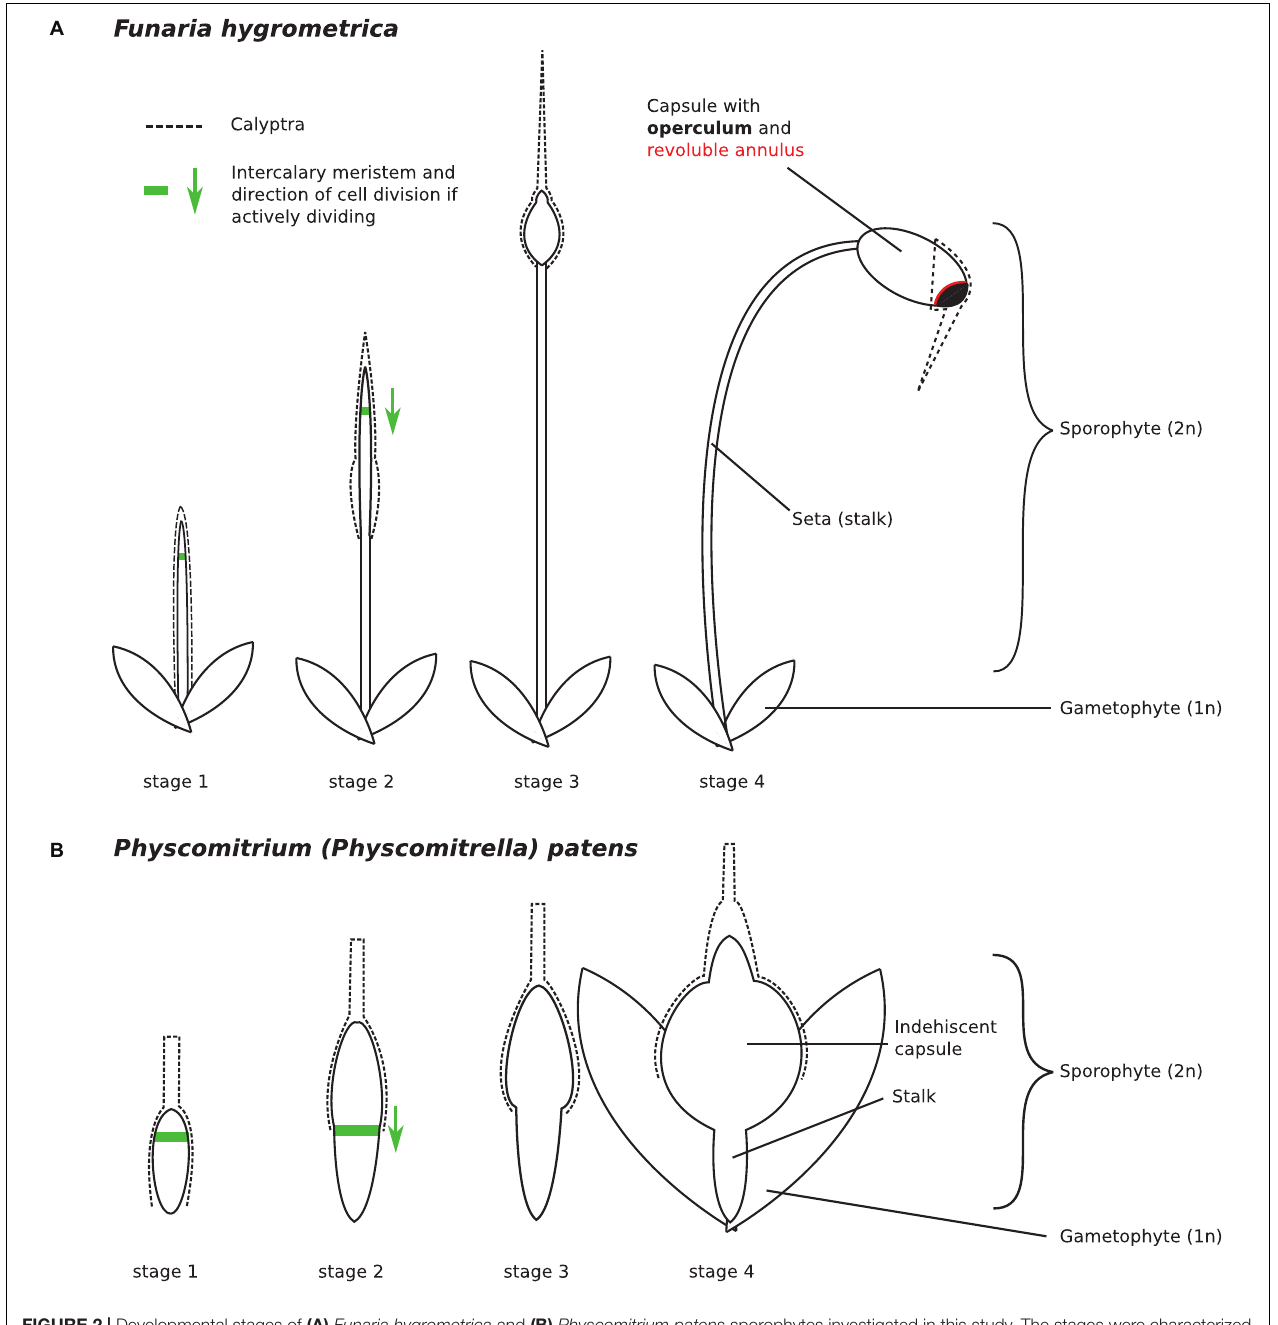
FIGURE 2 | Developmental stages of (A) Funaria hygrometrica and (B) Physcomitrium patens sporophytes investigated in this study. The stages were characterized as follows: stage 1 – sporophyte emerges from gametophytic tissue, stage 2 – elongation of the seta occurs, stage 3 – sporophyte reaches its final height, capsule begins to swell, stage 4 – capsule has swollen to its final size and all specialized structures are established but meiosis has not occurred yet. Presence of the green arrow indicates that the intercalary meristem (green line) is likely active and shows the direction of cell division. The F. hygrometrica sporophyte reaches a final size of 5 cm, the P. patens sporophyte grows to a size of 1 mm. The calyptra (dashed line) is developed from the archegonium and as such, is not part of the